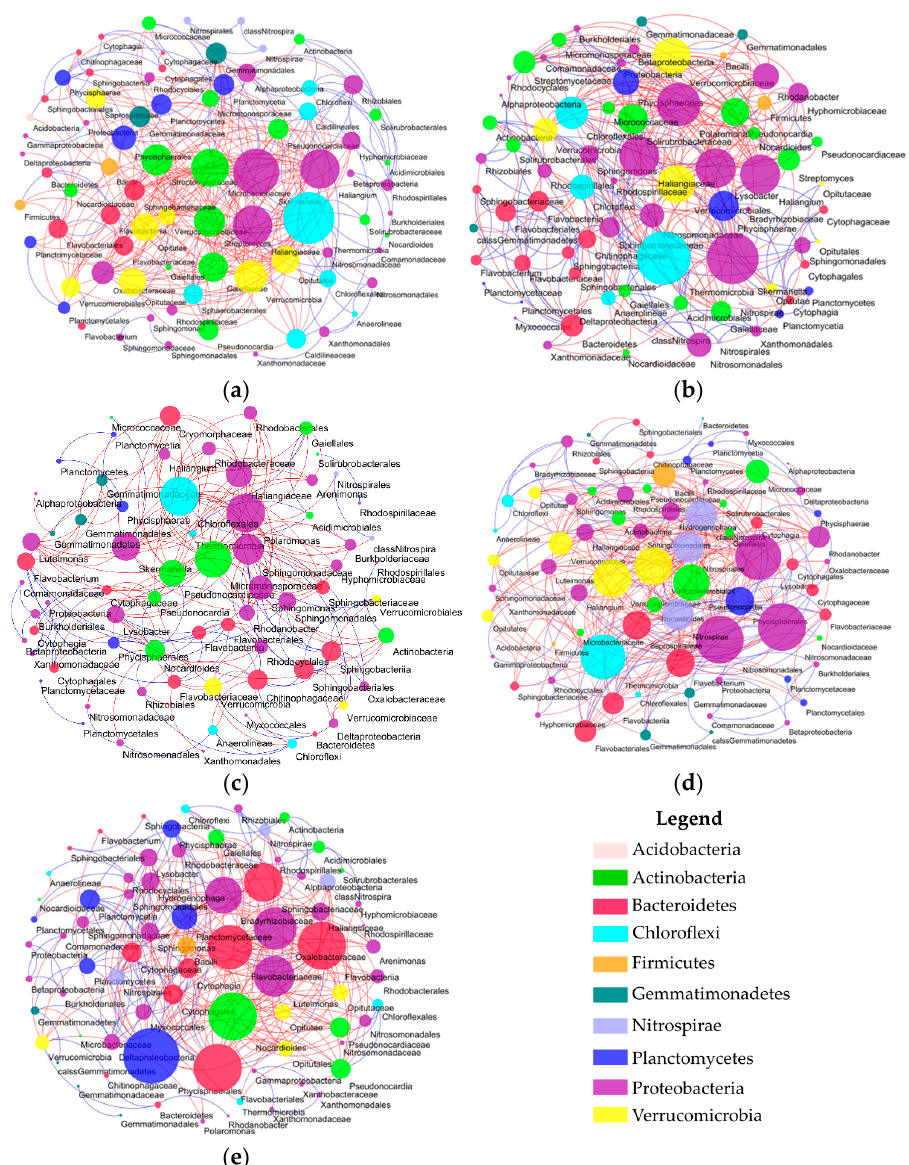
Figure 4. Profiles of the networks under five di ff erent CO 2 concentrations, with the node size proportional to node degree: ( a ) network C; ( b ) network L; ( c ) network M; ( d ) network H; ( e ) network E. A red link indicates negative correlation and a blue link positive